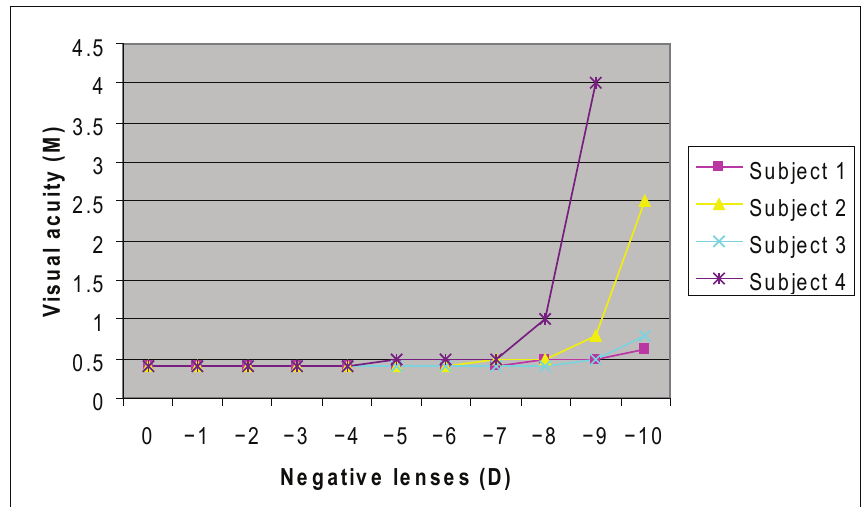
Figure 7. Effect of negative lenses on visual acuity while viewing a near acuity chart without a pinhole and illumination of 460 lux.